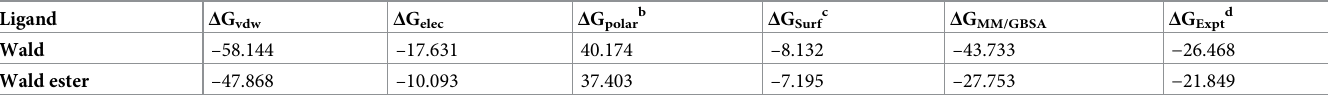
Table 2. Calculated binding free energies in comparison with experimental data (kcal mol –1 a